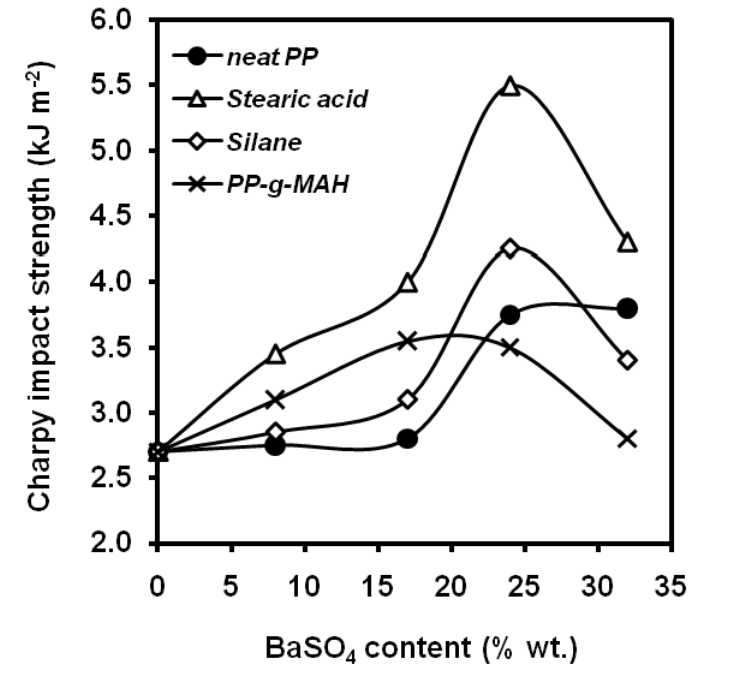
Figure 25. Influence of barium sulphate content on the notched Charpy impact strength of PP composites with differences in matrix-filler interphase (adapted from [87]).